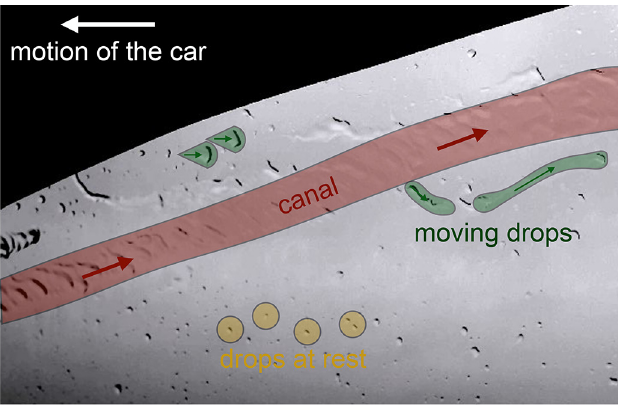
Fig. 1. Picture of rain drops on the side window of a moving car. The drops have different trajectories; some of them are going up, other have almost horizontal directions. Merging between drops occur, which makes the different paths quite erratic. The wetting of the window makes it easier to take some prede fi ned paths (canals), as we can see on the top part on the window.